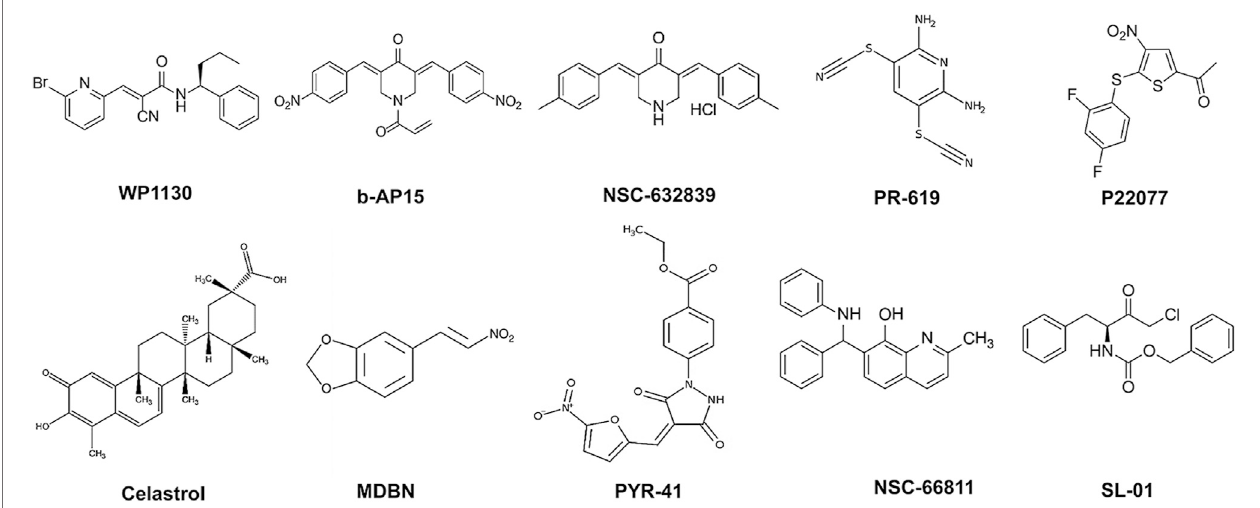
FIGURE 2 | 2D-Chemical structures of the lead compounds. WP-1130, b-AP15, NSC 632839, PR-619, P22077, Celastrol, MDBN, PYR-41, NSC 66811, and SL-01.